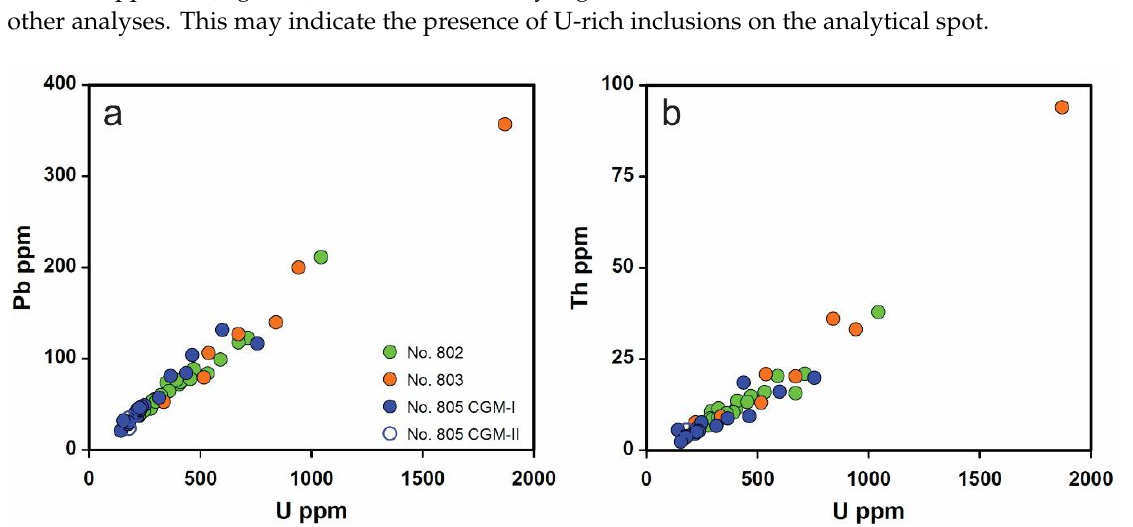
Figure 10. Correlations between Zr/Hf ratios and W, Sn, and Y concentrations of the CGMs from the Li- rich pegmatites at Kalu’an. ( a ) Zr/Hf ratio versus W, ( b ) Zr/Hf ratio versus Sn, and ( c ) Zr/Hf ratio versus Y. 6. Discussion 6.1. Age Variation at Pegmatite Scale It is noted that 206 Pb/ 238 U ages show variation at pegmatite scale (Figure 7). Also, the 207 Pb/ 235 U ages show relatively large variation compared to the 206 Pb/ 238 U ages, which was also observed by Che et al. [14]. Scrutiny of the columbite U-Pb age data for individual pegmatites indicates that the large age variation is mainly related to the discordant ages (Figure 8). For example, for No. 802 pegmatites, the data points with discordant ages show 206 Pb/ 238 U ages ranging from 219.8 ± 3.2 Ma to 206.7 ± 4.6 Ma, whereas the data points with concordant ages show 206 Pb/ 238 U ages varying within a smaller range (215.7 ± 4.4 Ma to 207.2 ± 4.0 Ma) (Figure 8a, Table 3). For No. 803 pegmatites, the data points with discordant ages exhibit 206 Pb/ 238 U ages ranging from 211.6 ± 2.3 Ma to 191.0 ± 1.5 Ma, whereas the data points with concordant ages show 206 Pb/ 238 U ages varying between 202.5 ± 2.5 Ma and 187.3 ± 3.2 Ma.